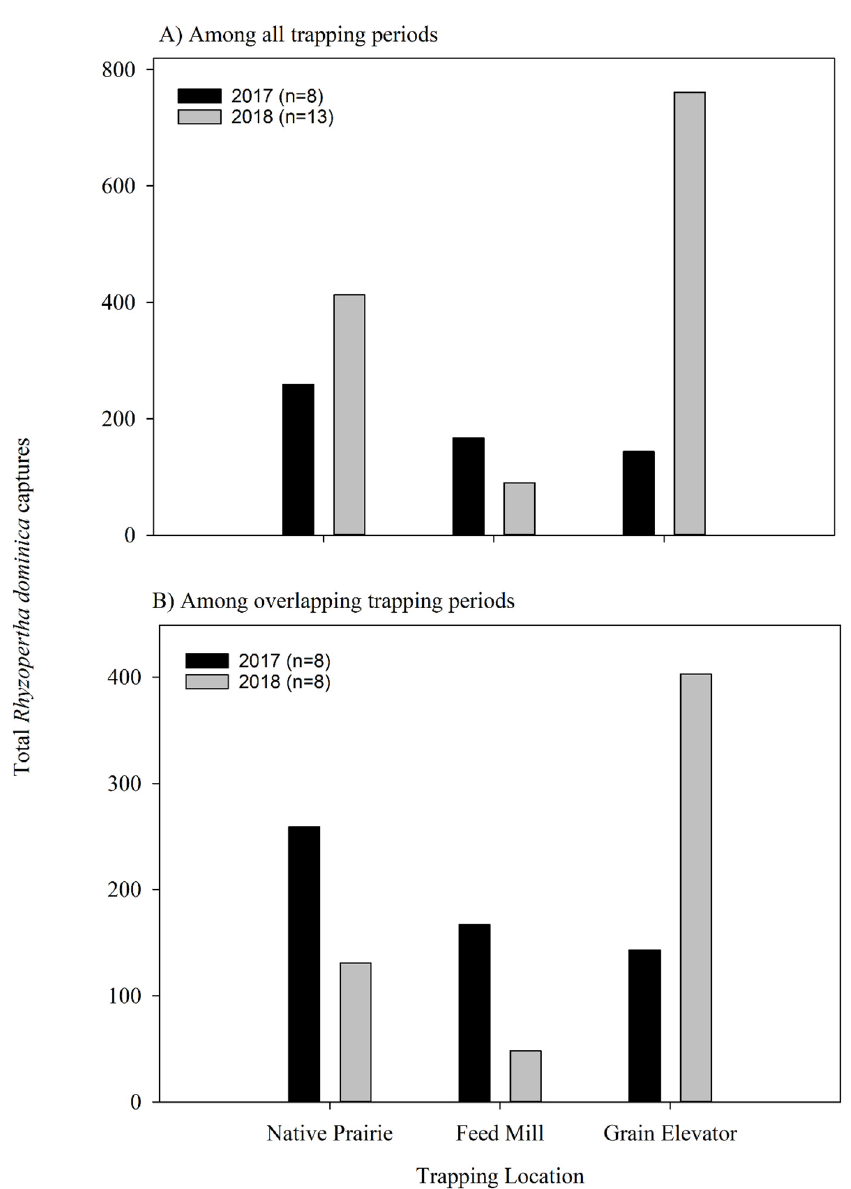
Figure 5. Total Rhyzopertha dominica captures in Lindgren traps across all attractant types for ( A ) all trapping periods (2017 trials 6–13 and 2018 trials 1–13) or ( B ) overlapping trapping periods of trials per year (trials 6–13 for 2017 and 2018). Black bars represent 2017 captures and gray bars represent 2018 captures.